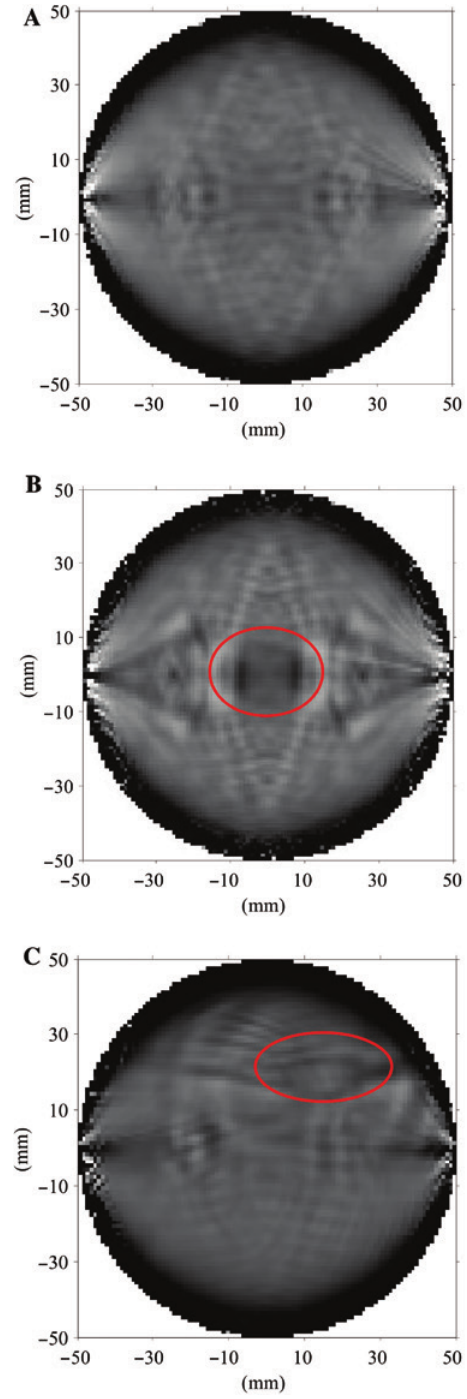
Figure 6: Tomographic images reconstructed using the original TOF data of the three models: (A) an unflawed model, (B) a flawed model with a hole in the center, and (C) a flawed model with a hole in coordinates (15,20).